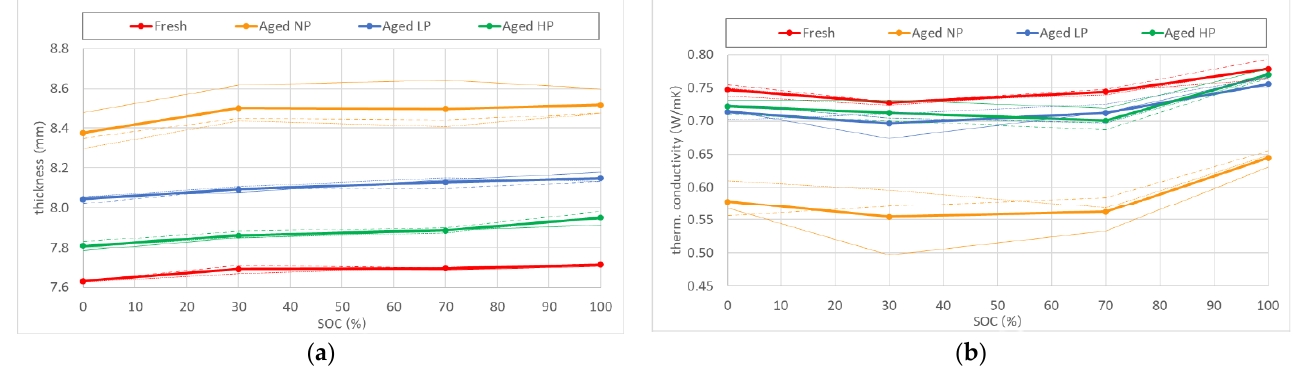
Figure 2. ( a ) Thickness increase with SOC for different aged cells ( b ) Influence of product life on the thermal conductivity of cells aged under different compression forces.